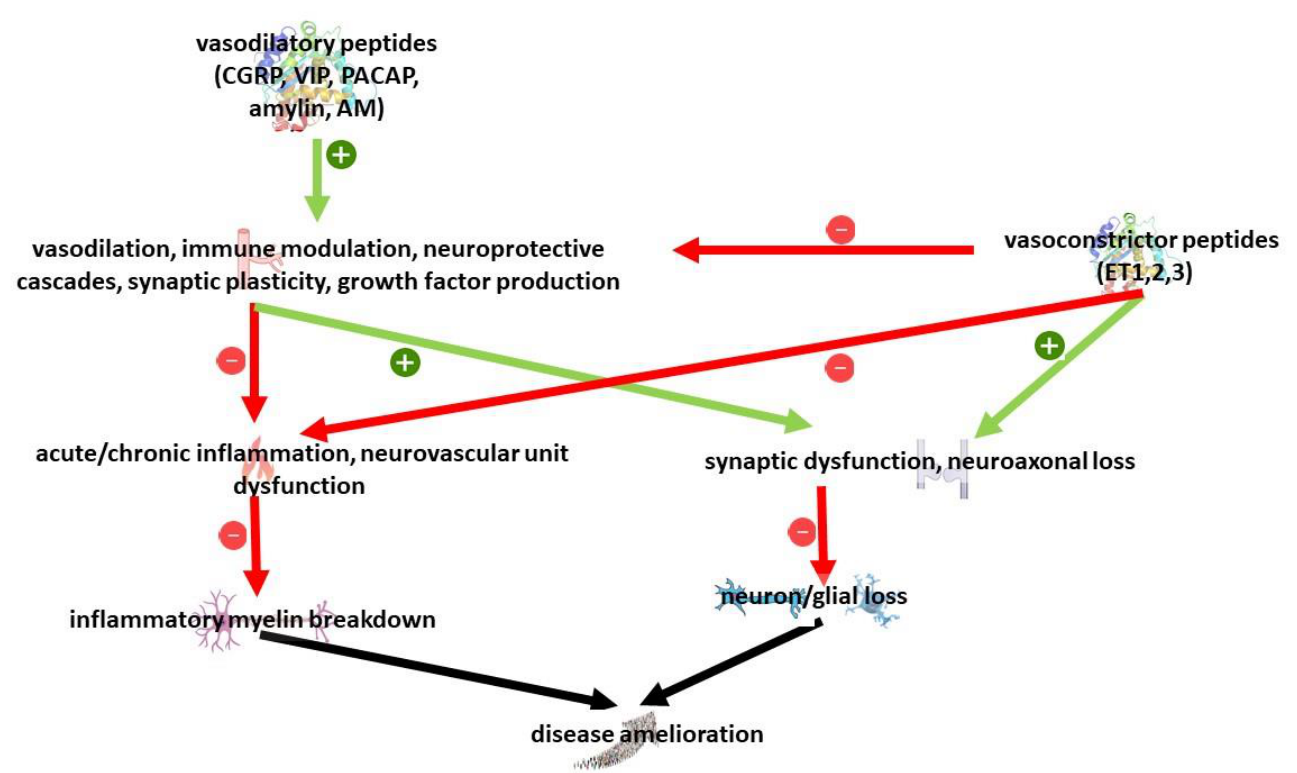
Figure 2. Overview of relevant pathways to MS pathology regulated by vasoactive peptides.